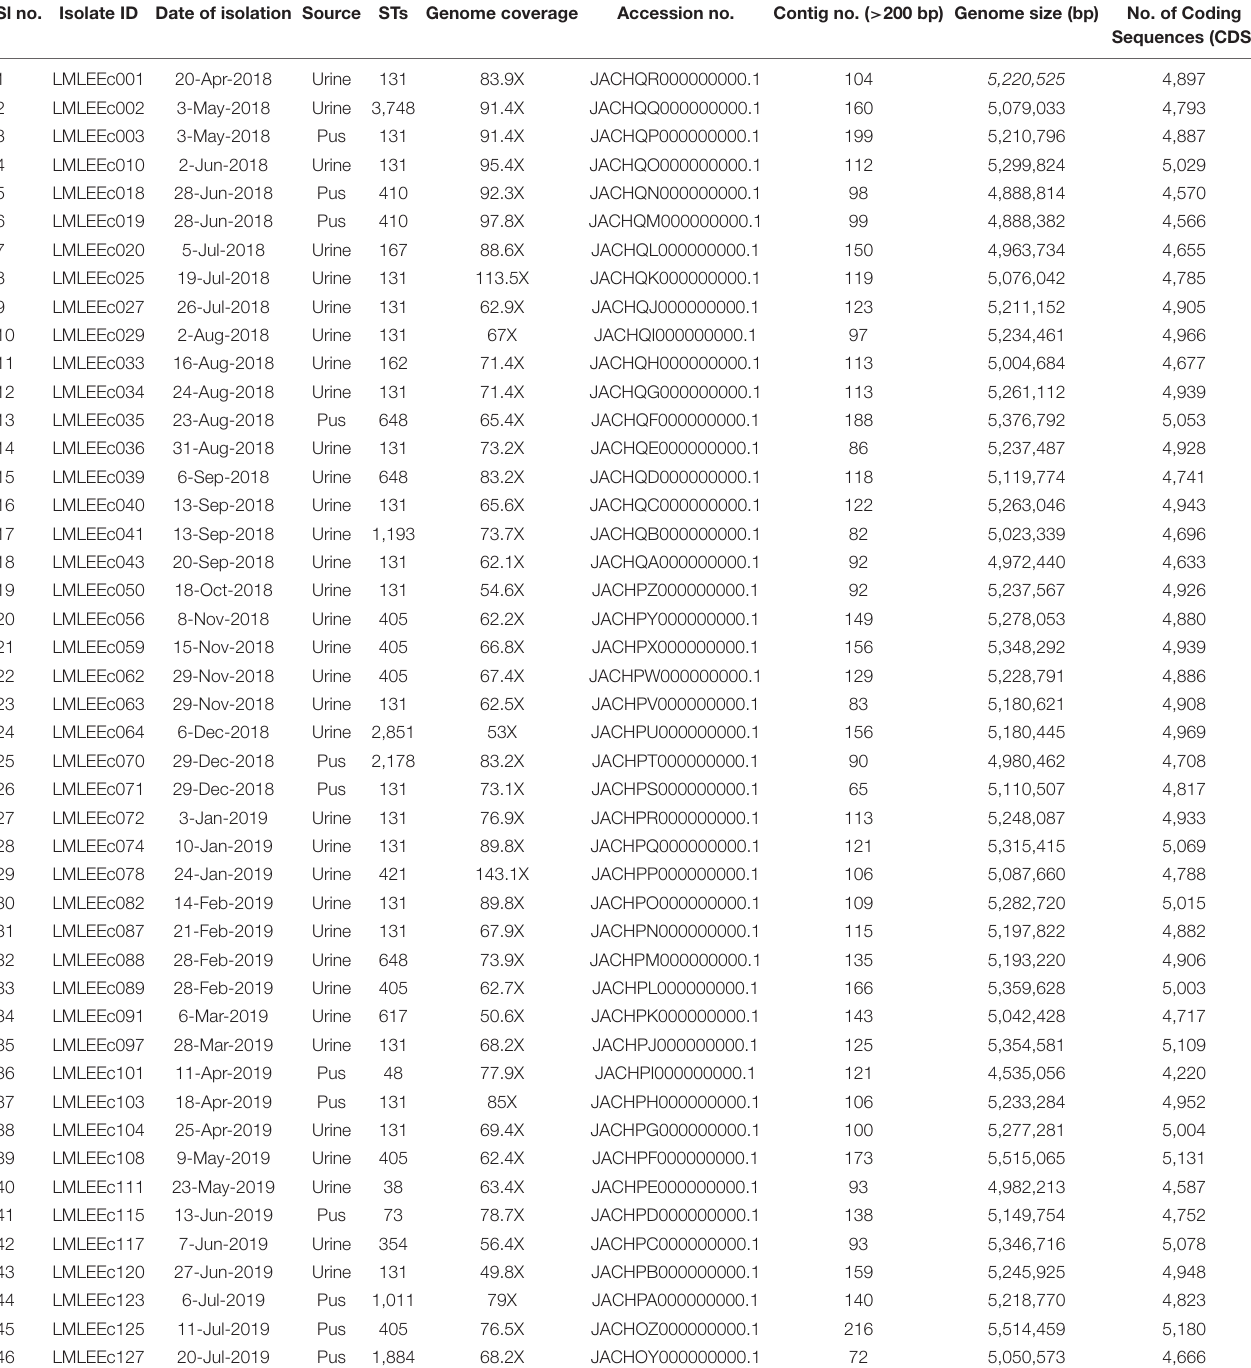
TABLE 1 | Genome features and metadata of 46 ESBL E. coli isolates sequenced in this study. Sl no. Isolate ID Date of isolation Source STs Genome coverage Accession